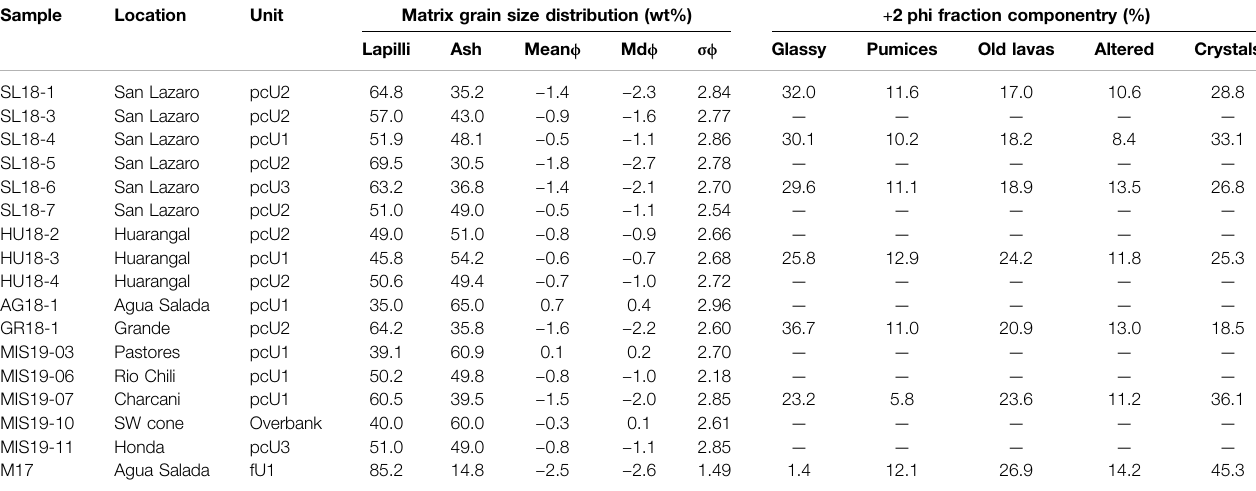
TABLE 2 | Matrix grain size distribution (in weight %) of the studied samples and lithological component abundances [% with 700 < N (number of particles) < 1,000] of the +2 phi fraction of selected samples Sample Location